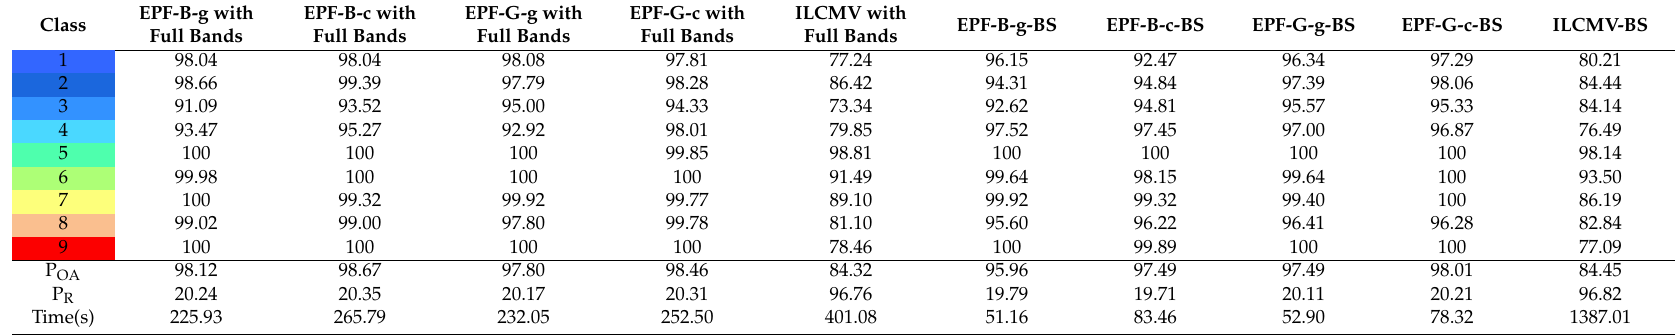
Table 13. P OA and P R calculated by the classification results using full bands and the bands selected by SQ LCMV-BSS-1 in Table 2 for University of Pavia. Class